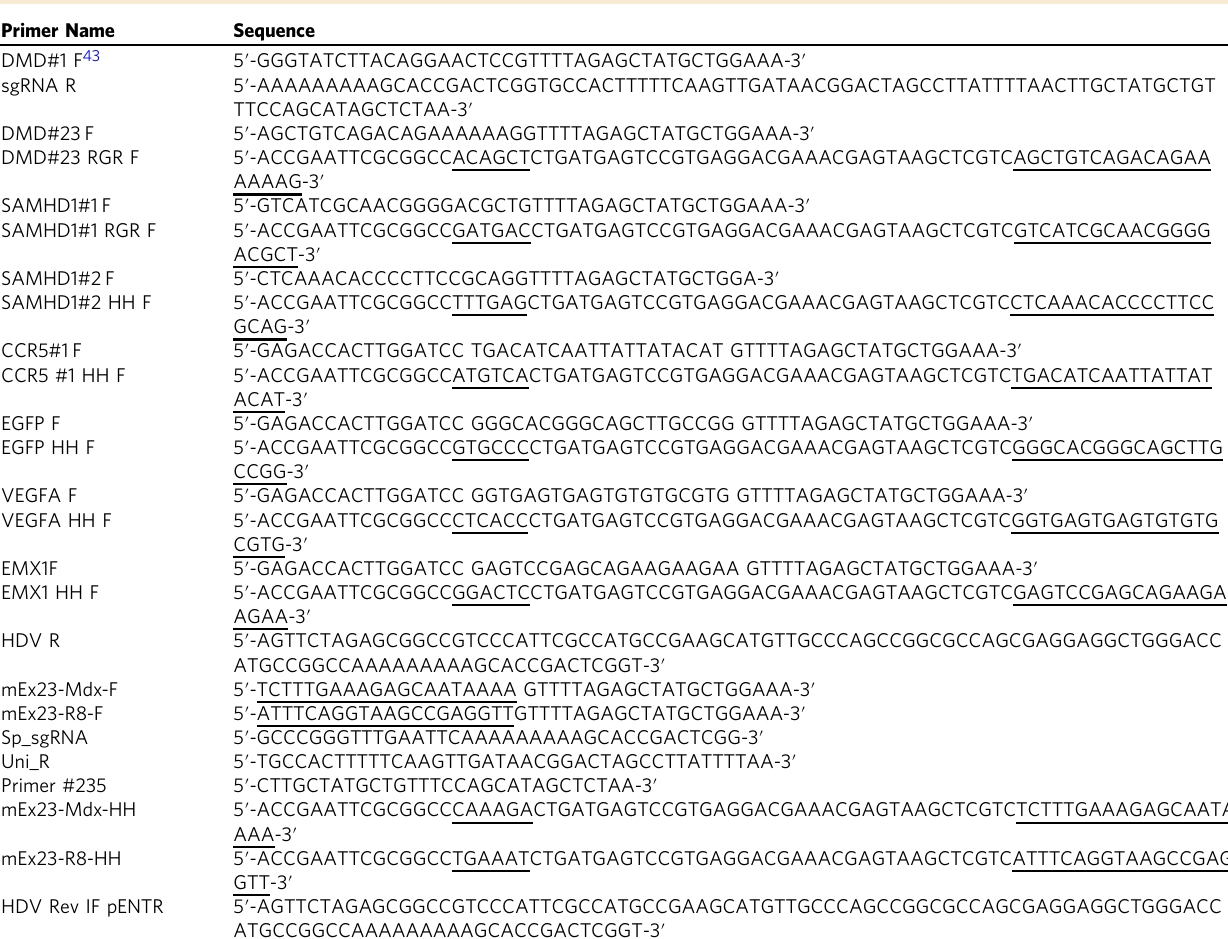
Table 4 Primers used for gRNA cloning.